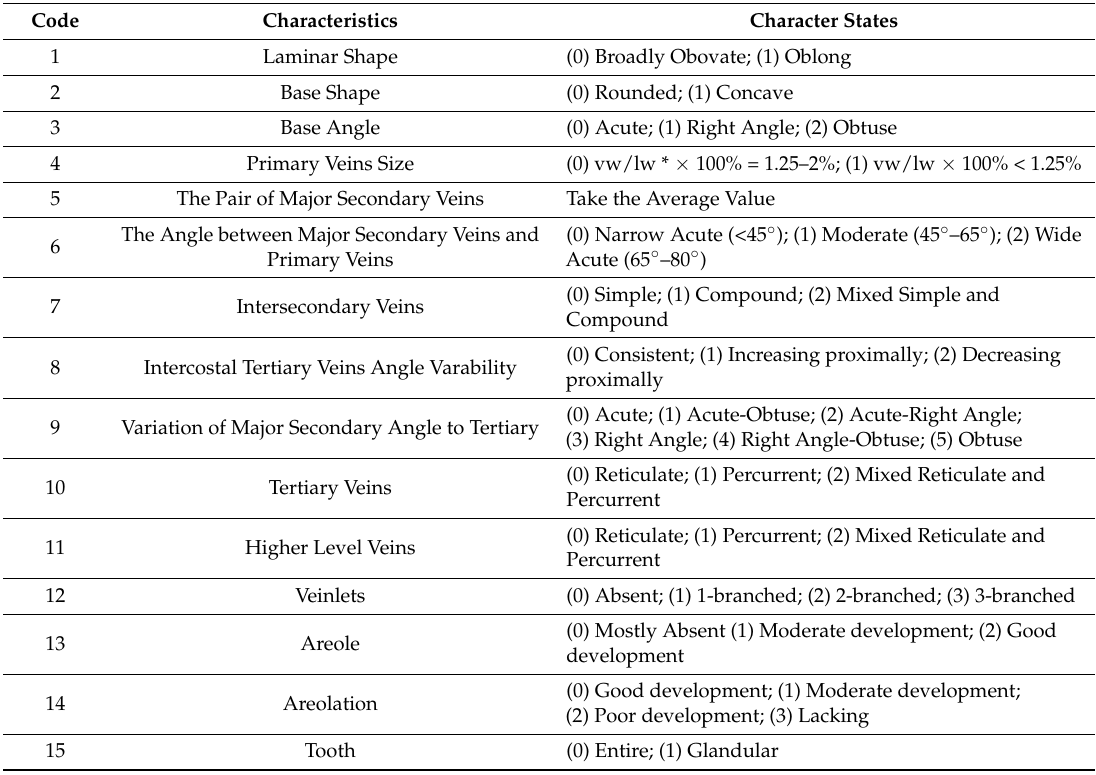
Table 2. Fifteen leaf venation characteristics of P. subaequalis